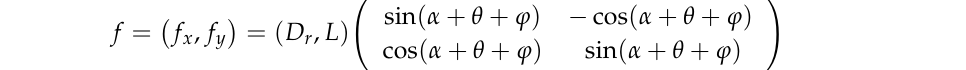
D when the water r